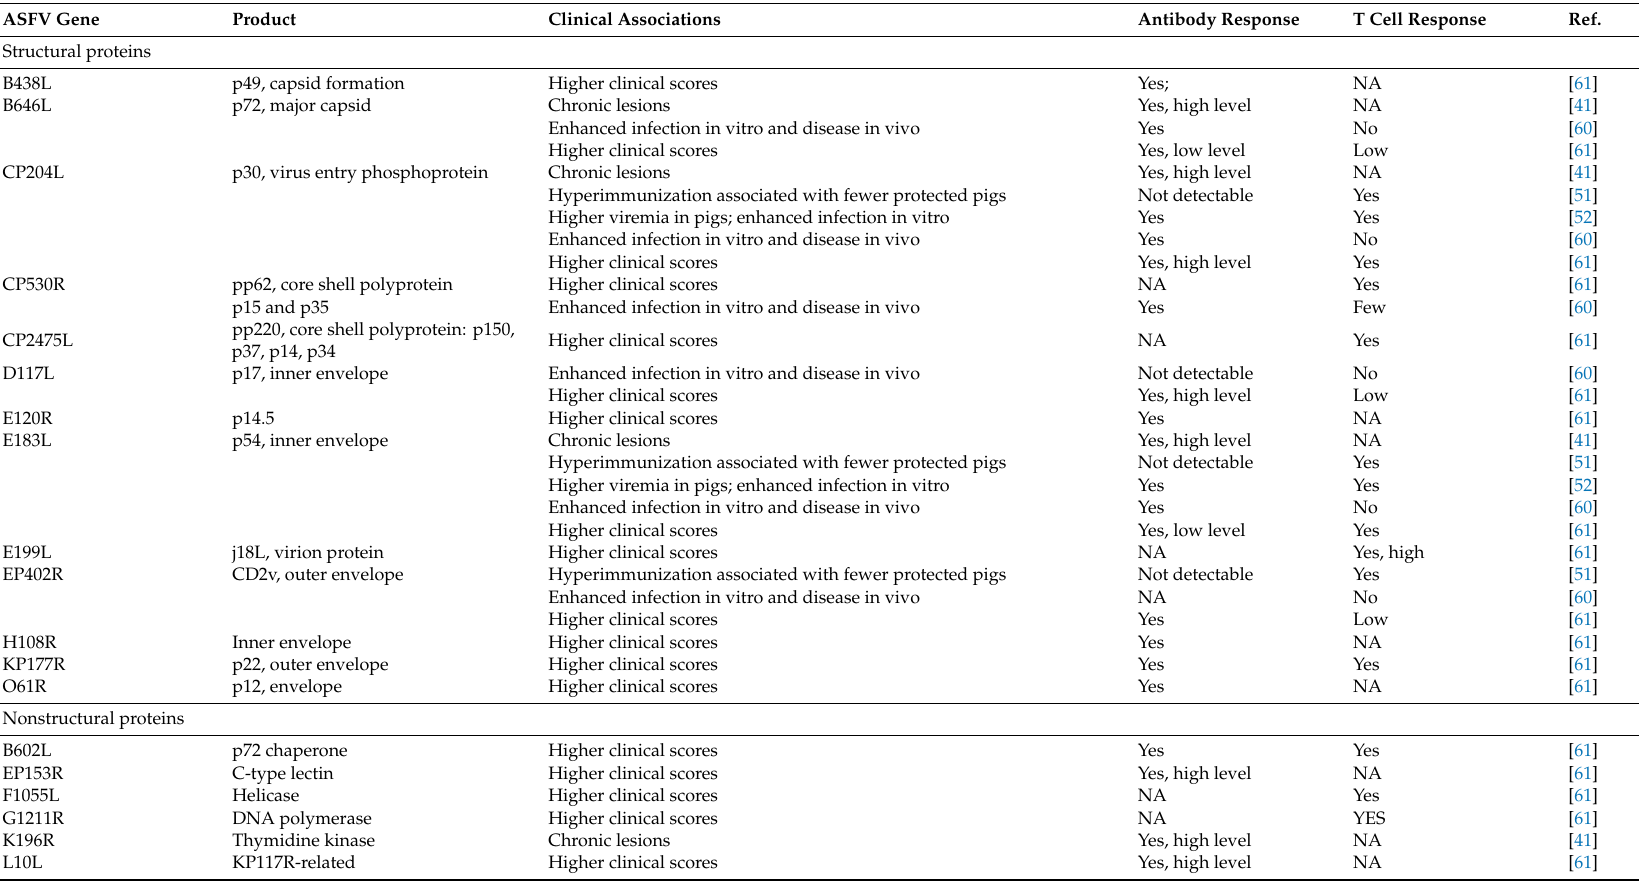
Table 7. ASFV immunogens associated with immune-enhanced